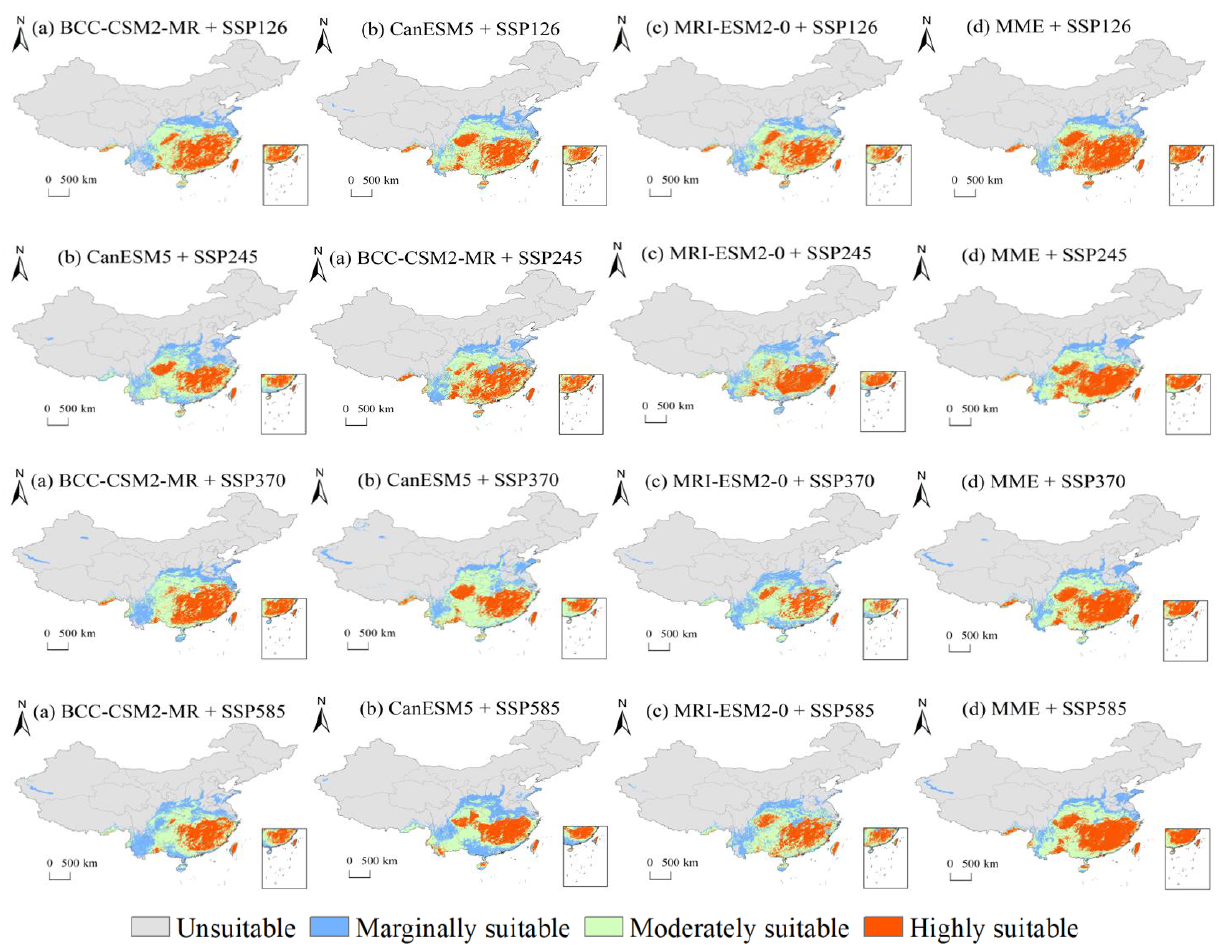
Figure 6. Potential suitable area for C. lanceolata in the three models and MME under four